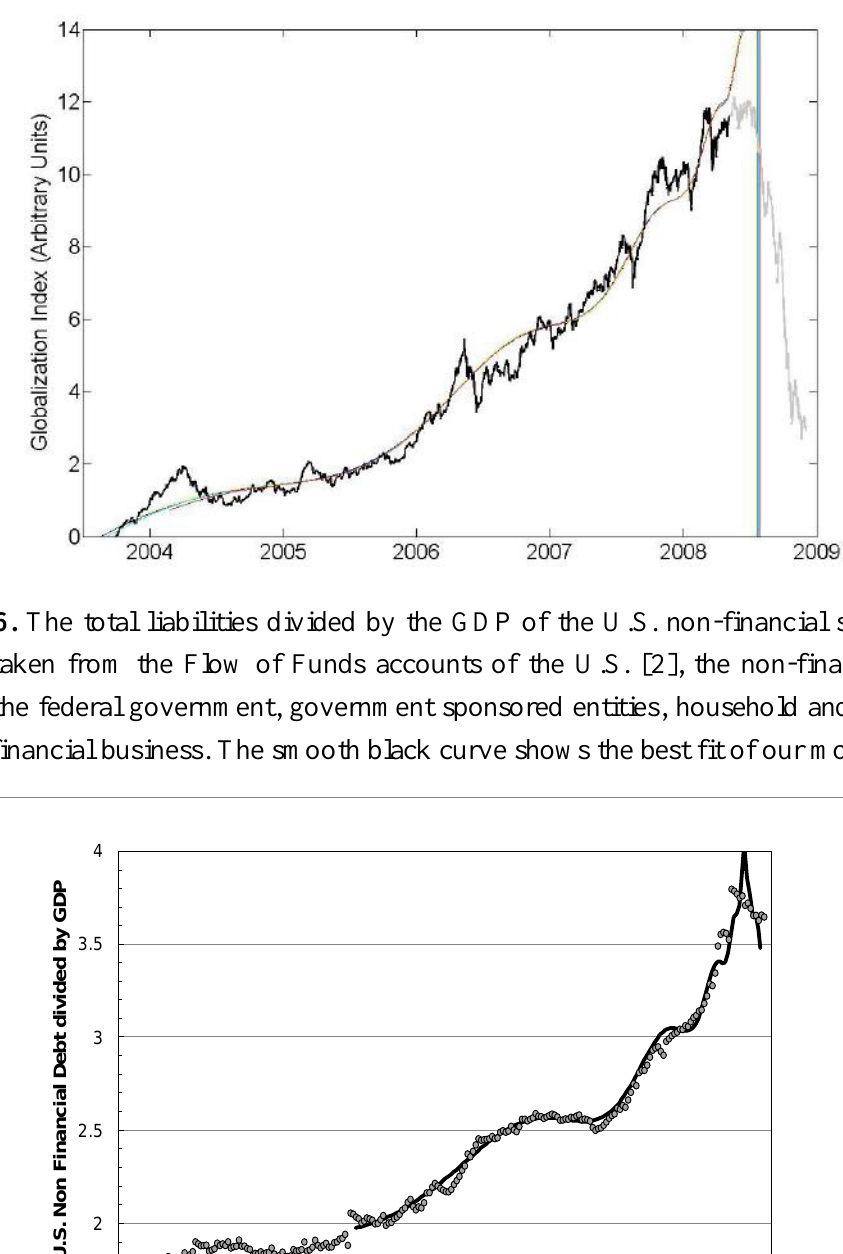
Figure 15. The globalization bubble. The time series represent a proprietary index of emerging markets equities and currencies, freight prices, soft commodities, base and precious metals and energy. The smooth curves show the fit of the model, the vertical green line is the best estimate of the correction time. Only the black data was used to calibrate the model back in 2008.